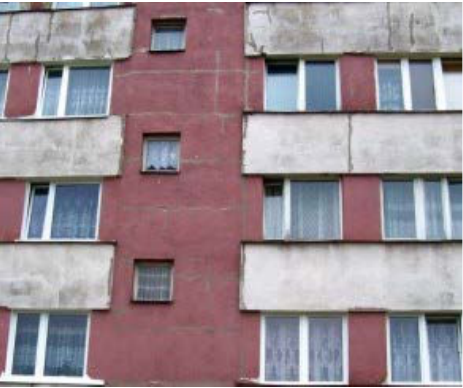
Figure 6. Exterior wall finish biocorrosion with different colors (author’s archives).